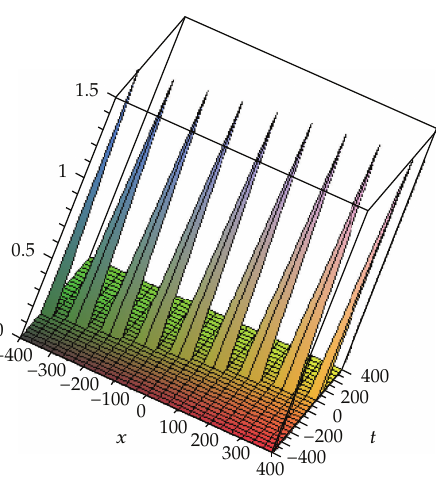
Figure 6: Solitons solution for y (cid:8) 0 and z (cid:8)